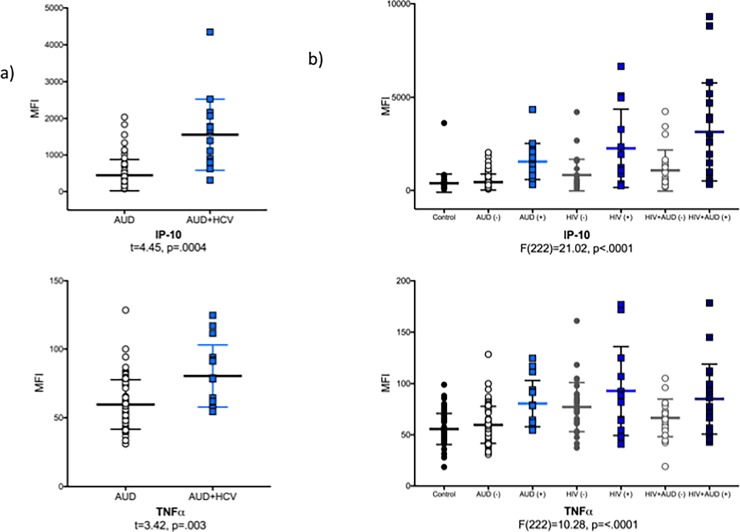
Scatter plots of Interferon γ-induced Protein 10 (IP-10) and Tumor Necrosis Factor α (TNFα) in a) the AUD group by HCV status (i.e., AUD without HCV: open black circles; AUD+HCV: blue squares) and b) all 4 study groups by HCV status (Control: black closed circles; AUD (-): AUD without HCV, black open circles; AUD (+): AUD +HCV, blue squares; HIV (-): HIV without HCV, gray closed circles; HIV (+): HIV+HCV: dark blue squares; HIV+AUD (-): HIV+AUD without HCV, gray open circles; HIV+AUD (+): HIV+AUD+HCV, midnight squares).